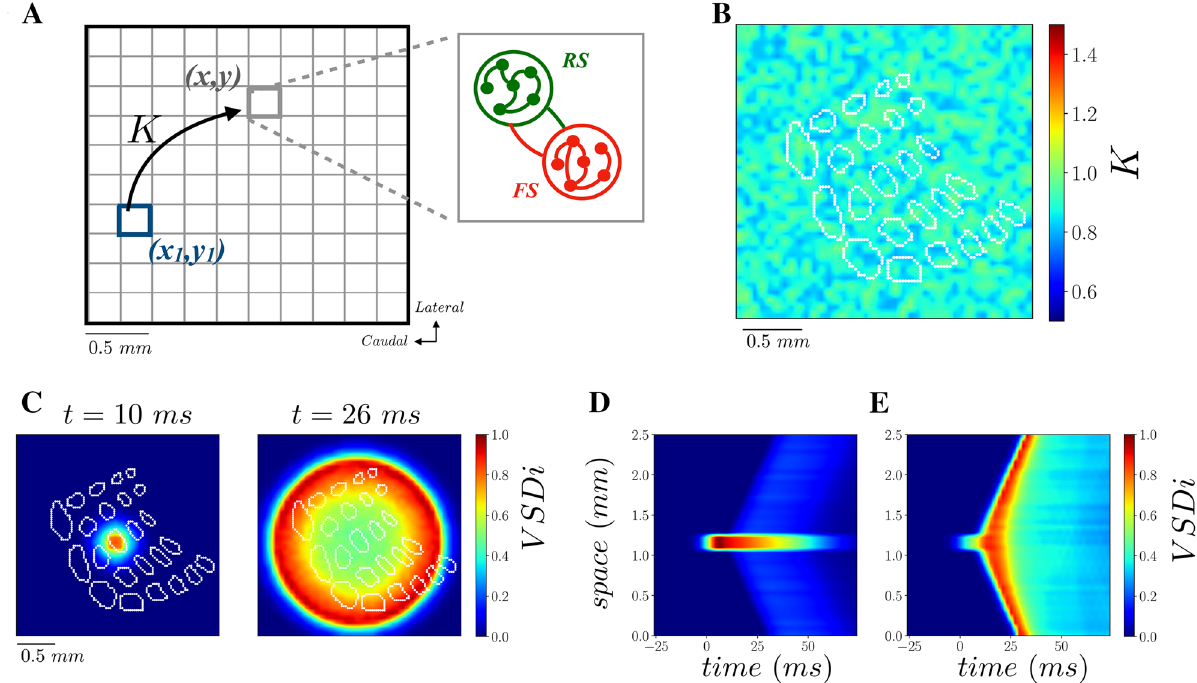
Figure 2. Computational model of S1. (A) A two dimensional lattice is considered to model activity in S1. Each point at a location (x,y) is modelled as a population of adaptive excitatory Regular Spiking (RS) and non- adaptive Fast Spiking (FS) inhibitory neurons. ( B) The strength of the excitatory incoming synapses (quantal conductance) Q E = Q 0 E * K(x,y) is homogeneously distributed around its average Q 0 E (K is extracted from a flat distribution with average < K > = 1 and width ΔK = 0.4). The color plot shows the values of K in the lattice for this flat and homogeneous distribution. ( C) Activity pattern with the distribution as in ( B) a pulse of stimulation in C2 at time t = 0 ms evokes an isotropic propagating wave. ( D) Spatio-temporal activity along the vertical direction passing by C2, same parameters as in ( C) . ( E) Spatio-temporal activity along the vertical direction passing by C2 with a uniform K , as in (D) , but with a lower average < K > = 0.4 (instead of < K > = 1 in panel B–D